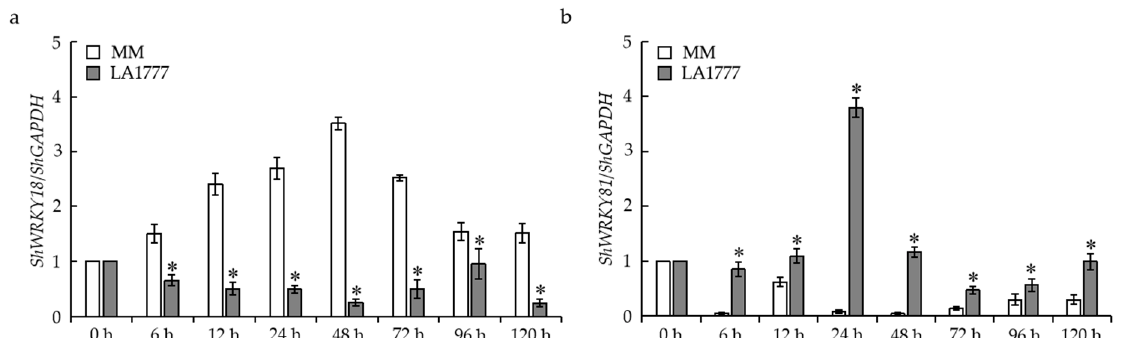
Figure 1. The mRNA accumulation of two WRKY genes in resistant wild tomato LA1777 and susceptible tomato cultivar (MM) following On -lz infection. Quantitative real-time PCR expression analysis of WRKY18 ( a ) and WRKY81 ( b ) in tomato leaves at 0, 6, 12, 24, 48, 72, 96, and 120 hpi (hours post inoculation). The glyceraldehyde-3-phosphate dehydrogenase ( GAPDH ) gene was used as an internal reference. Values are shown as the means ± standard error of three biological replicates, and statistically significant differences in the compatible reaction and incompatible reaction at the same time point are represented by asterisks (Student’s t -test, *, p < 0.05).